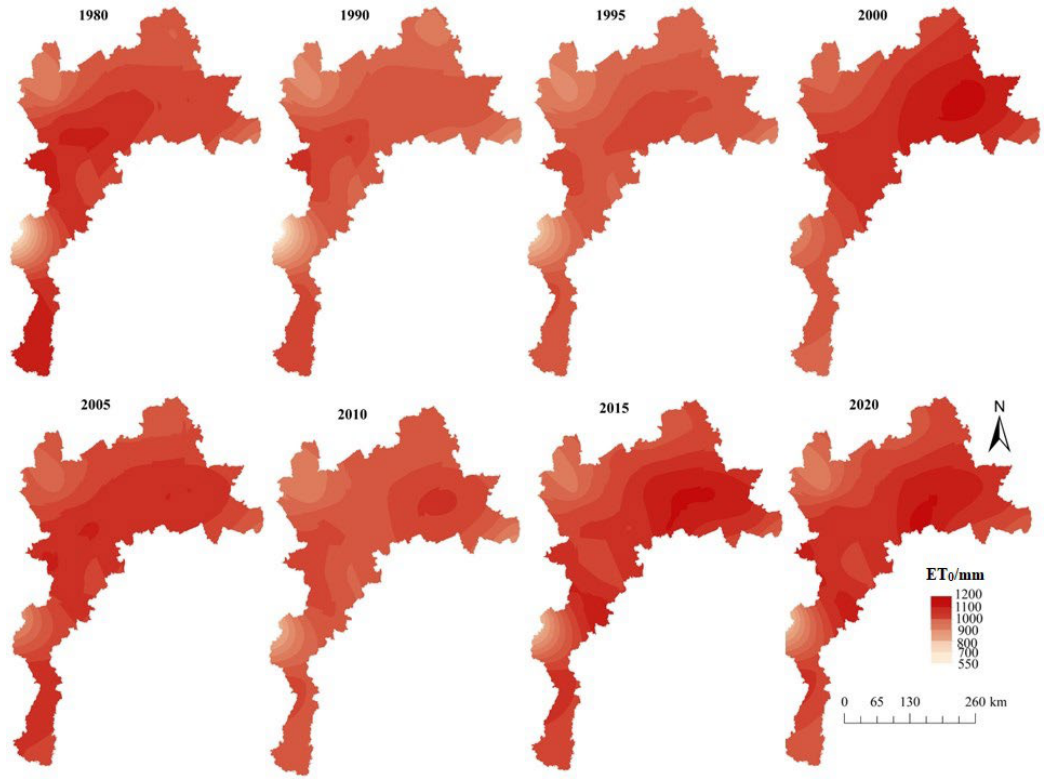
Figure 3. The spatial patterns of annual ET0 in the eight years during 1980–2020. The potential evapotranspiration showed a clear opposite trend to precipitation.